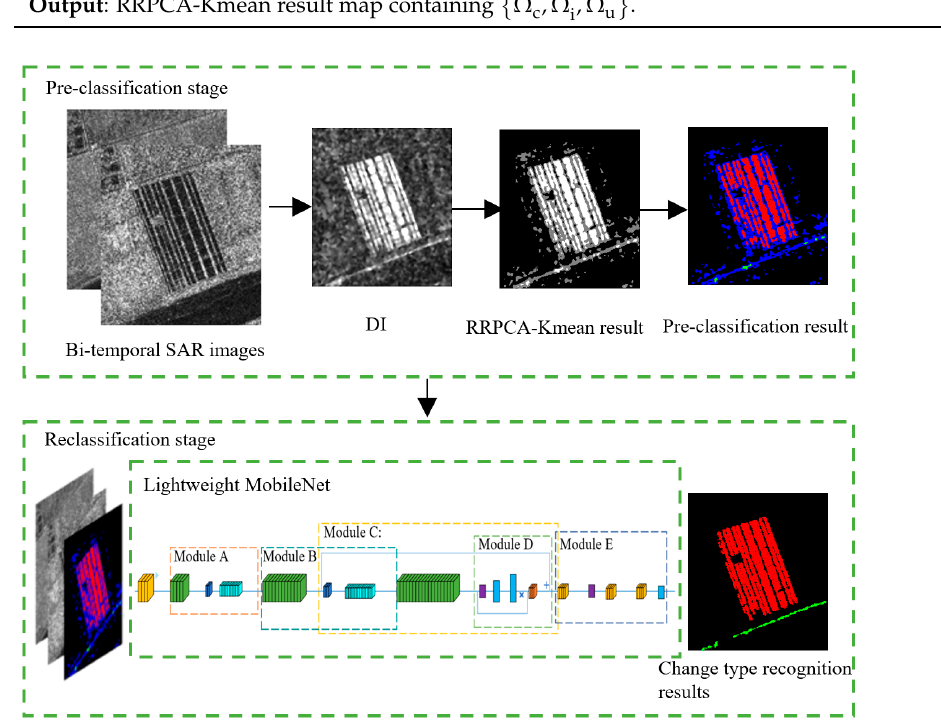
Figure 1. Proposed LMNet change recognition